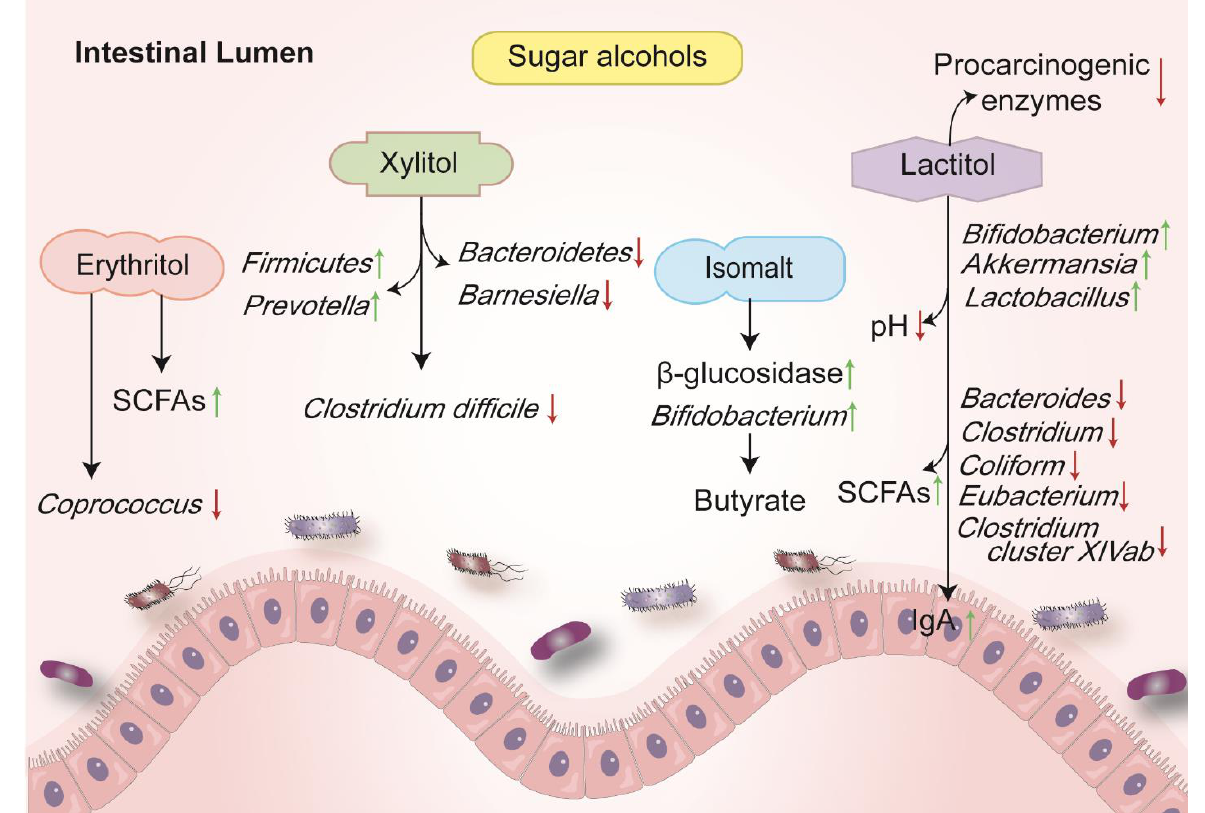
Figure 1. The impact of sugar alcohols on gut microbiomes and metabolites. “ ↑ ” means an increased level; “ ↓ ” means a decreased level.